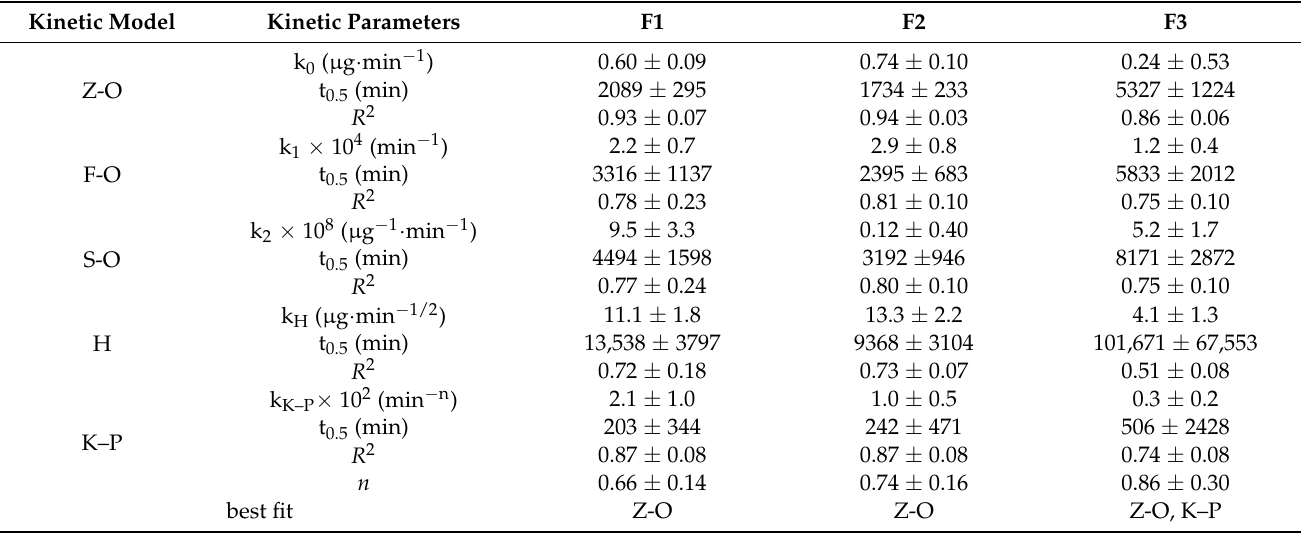
Table 3 . The kinetic parameters of HA release from formulations F1–F3.